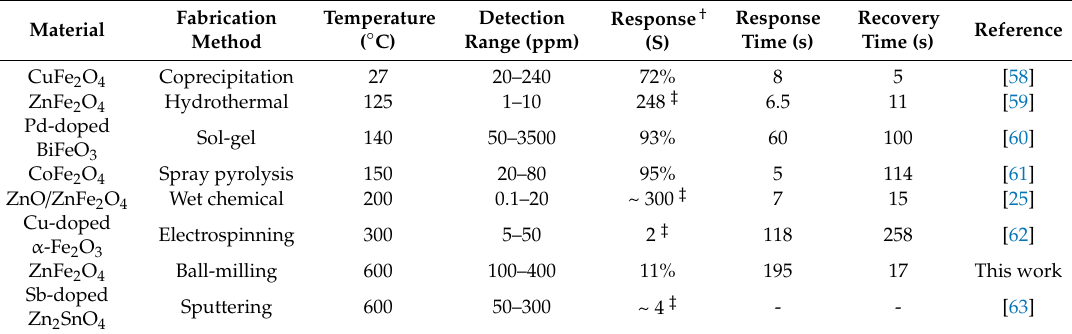
Table 3. A comparison of the sensing properties of chemiresistive-type NO 2 gas